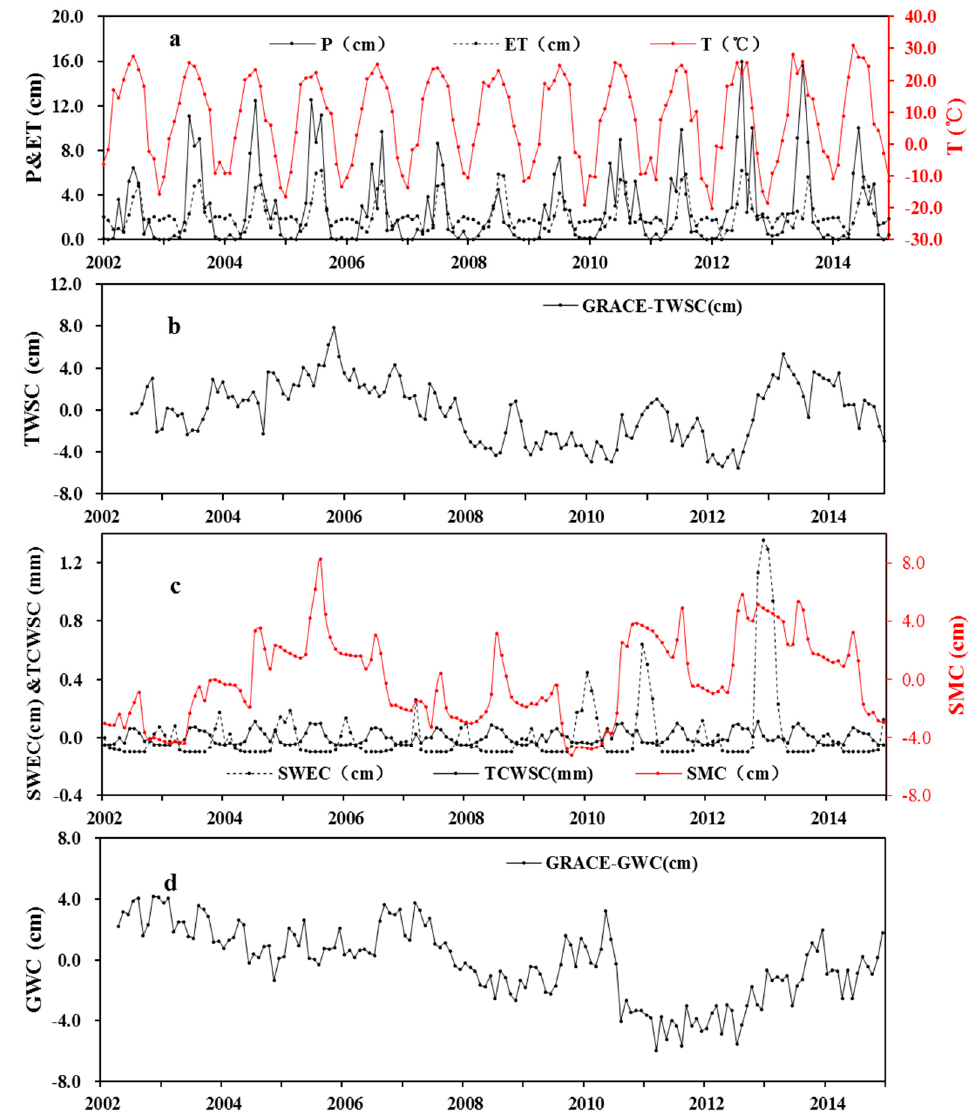
Figure 2. Changes of hydrometeorological factors in XRB from 2002~2014 ( a ) P, T & ET; ( b ) TWSC; ( c ) SWEC, TCWSC & SMC; ( d ) GWC.